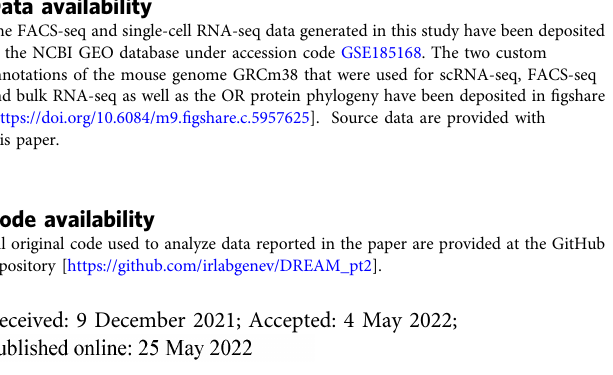
Supplementary Table 1. For transcriptional quanti fi cation by RNAscope, the experiment was performed once for each odor and included non-exposed mice in both experiments. Each experiment included several independent biological samples from each condition. For transcriptional quanti fi cation by standard in situ hybridization, the experiments was repeated four times and included both control and exposed samples in each